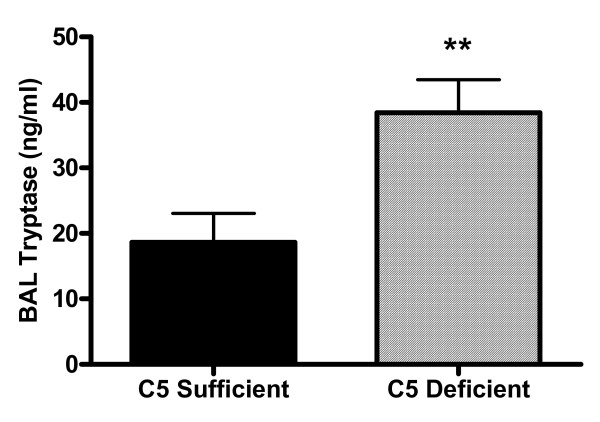
Bronchoalveolar lavage tryptase levels. Tryptase levels were determined by ELISA in the bronchoalveolar lavage fluid harvested at 48 hours after the last intratracheal challenge. C5 deficient mice had significantly higher levels of then these C5 sufficient mice. Values represent mean ± SEM with n = 11–15 for each group. **p < 0.01 compared to C5 Sufficient mice.